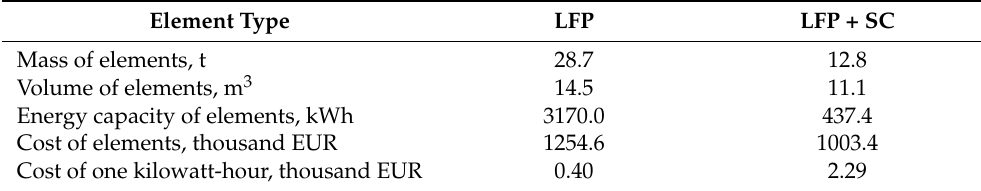
Table 5. Results of calculations of ES parameters with LFP elements and supercapacitors.